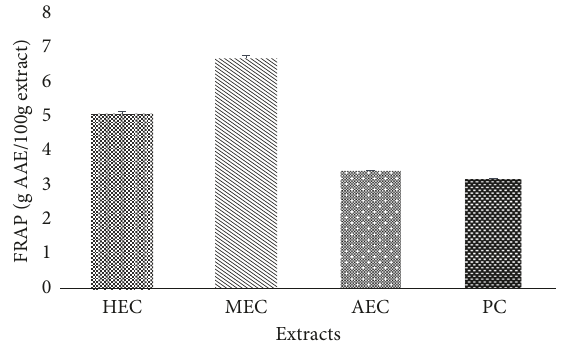
Figure 6: Reducing power of extracts of C. edulis . HEC : hydroethanolic extract Carissa ; MEC : methanolic extract Carissa ; AEC : aqueous extract Carissa ; PC : powder Carissa ; Vit C : vitamin C. n =